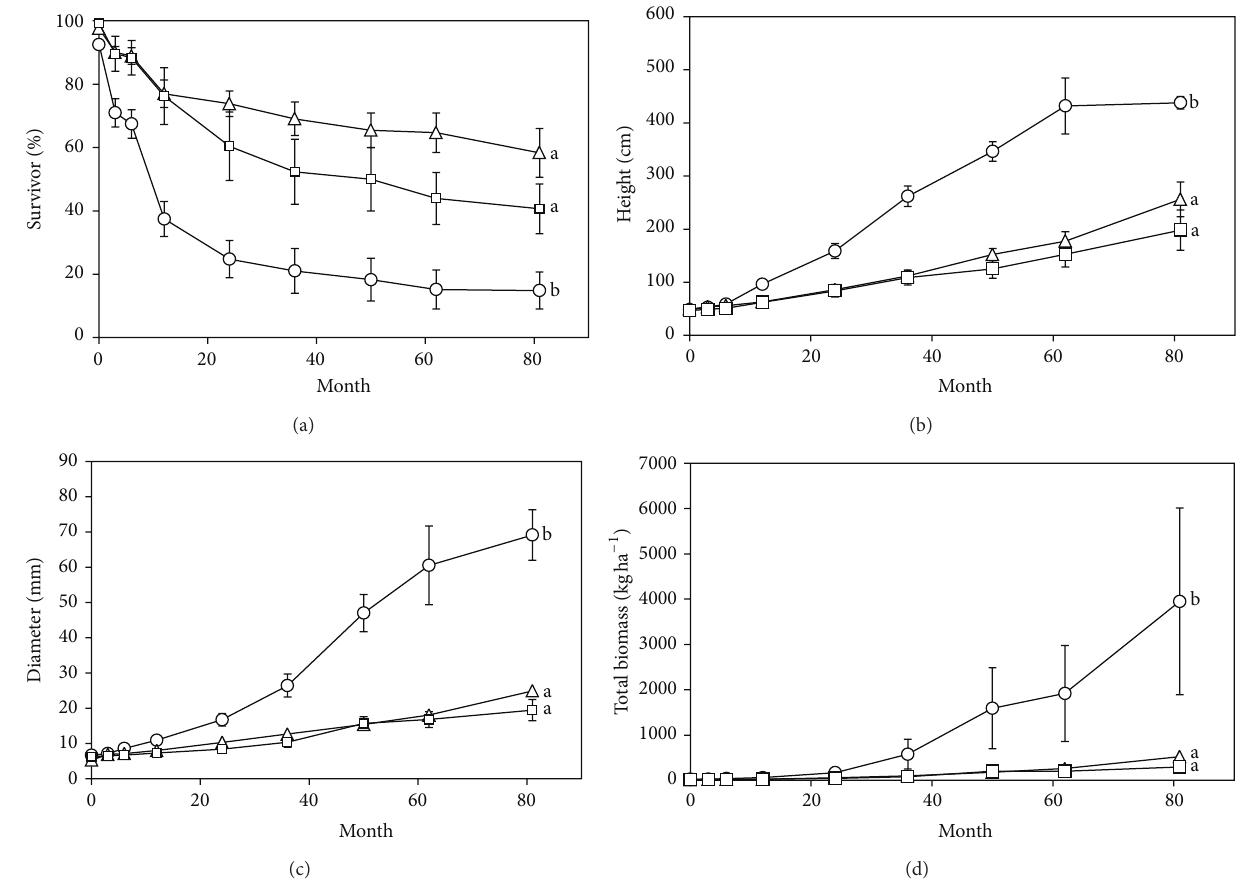
Figure 3: Percentage of survivor (%), height (cm), diameter (mm), and total biomass (kgha −1 ) of seedlings after planting. Different letters indicate significant differences by repeated measures ANOVA with Scheffe’s test over 81 months; I : grassland, 󳵻 : secondary forest, and ◻ : logged forest. 𝑃 < 0.001 for treatment and time effects (repeated measures